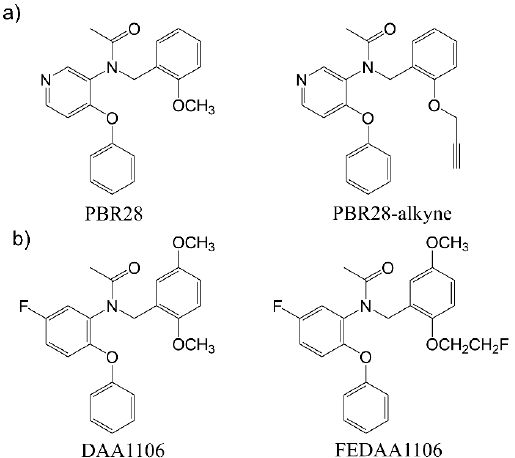
Figure 1. ( a ) Comparison of the molecular structure between PBR28 and the “clickable” PBR28-derivative synthesized in this work. ( b ) Molecular structures of two traditional TSPO ligands: DAA1106, FEDAA1106, PBR28 and the novel PBR28-alkyne.